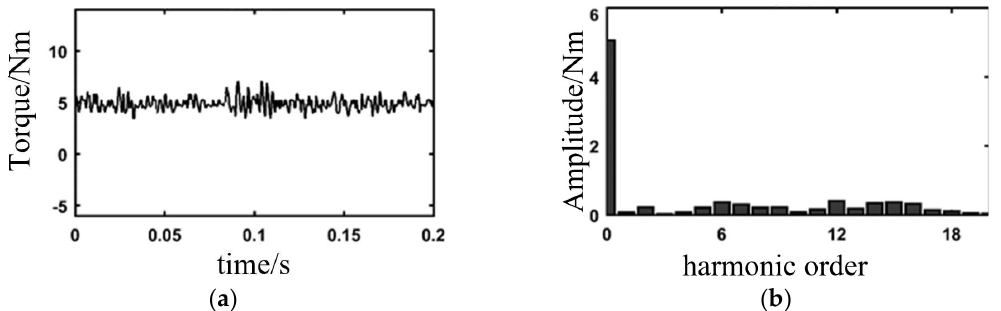
Figure 9. Experiment results with feedforward controller. ( a ) Torque wave; and, ( b ) FFT analysis of torque wave.